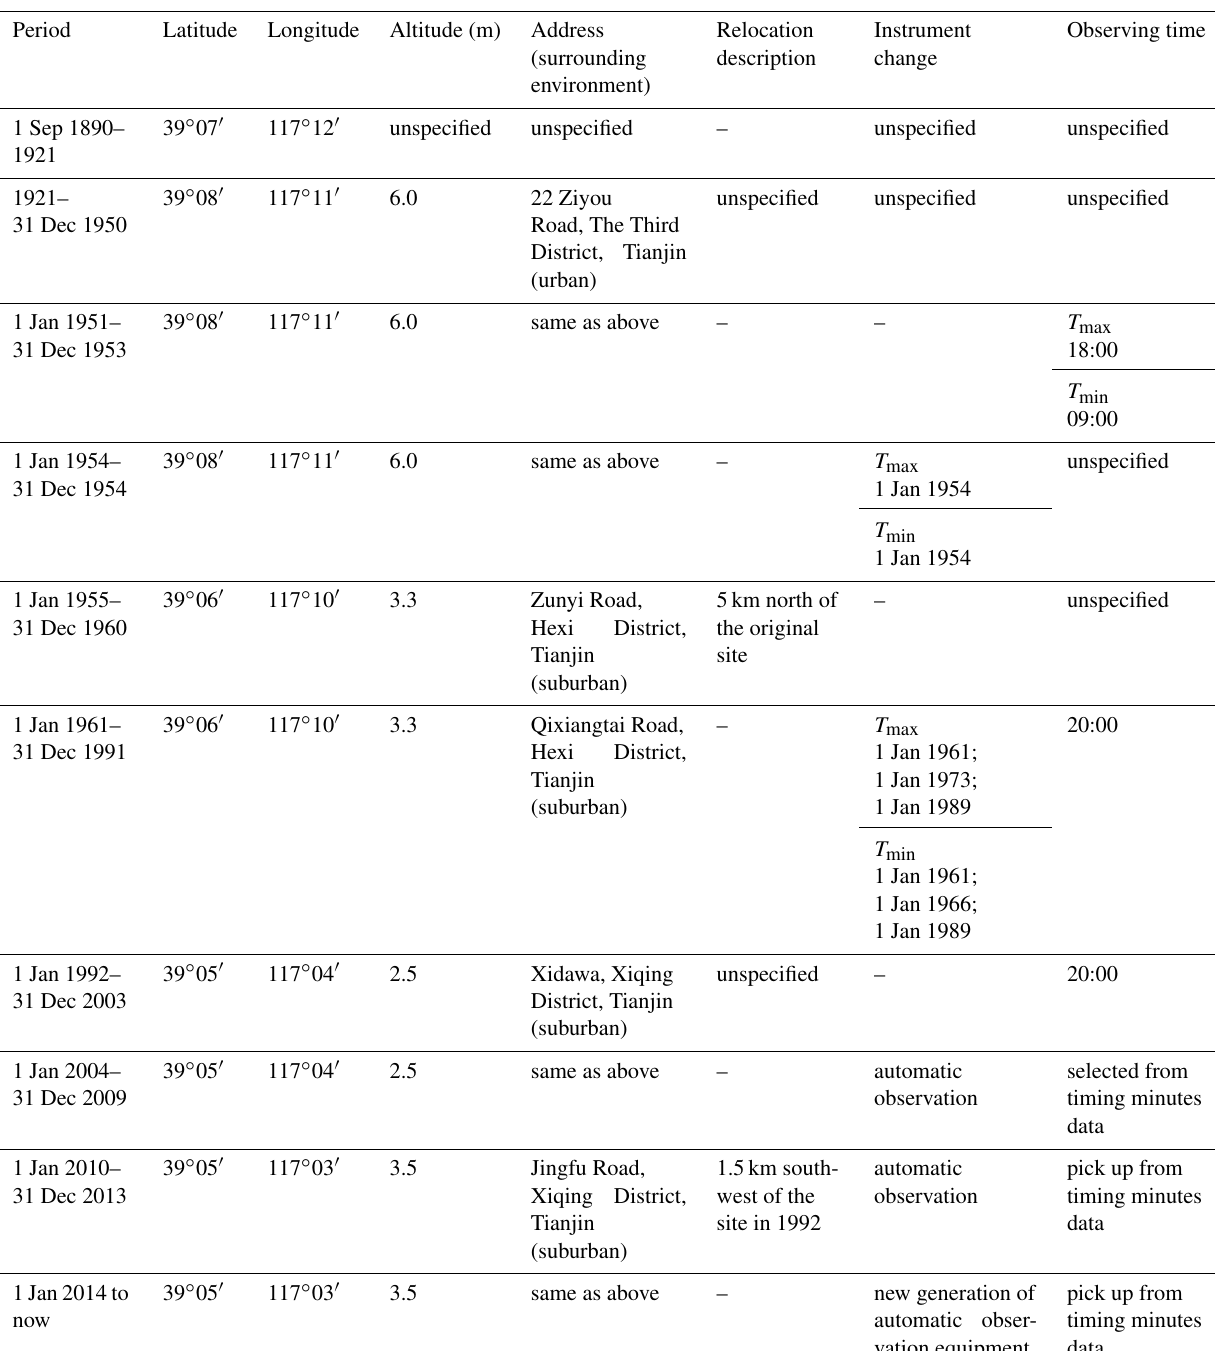
Table 1. The history logs at Tianjin Meteorological Observation Station during 1 September 1890–31 December 2019.